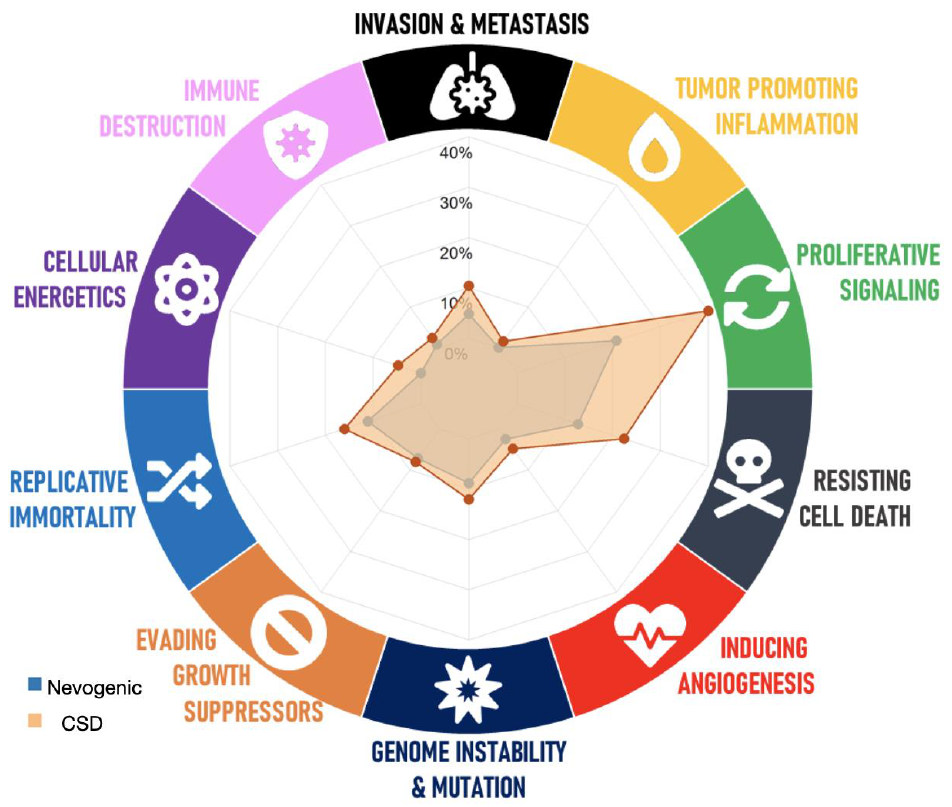
Figure 2. Radar plot of cancer hallmarks. This graphical representation shows the distribution of dysregulated circuits for each group. Percentages are used as an approximation to reflect the differences in the overall number of dysregulated circuits per hallmark found in each